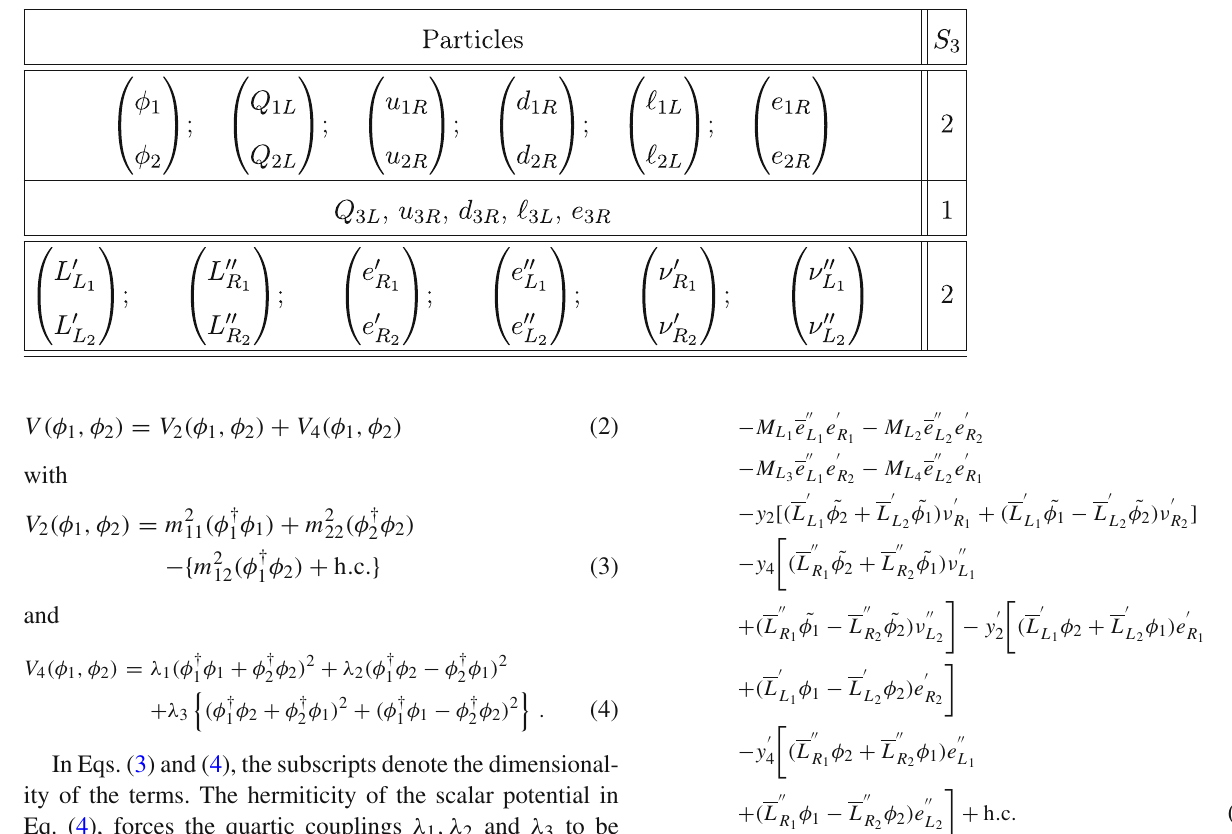
Table 2 S 3 quantum number assigned to the particles in the